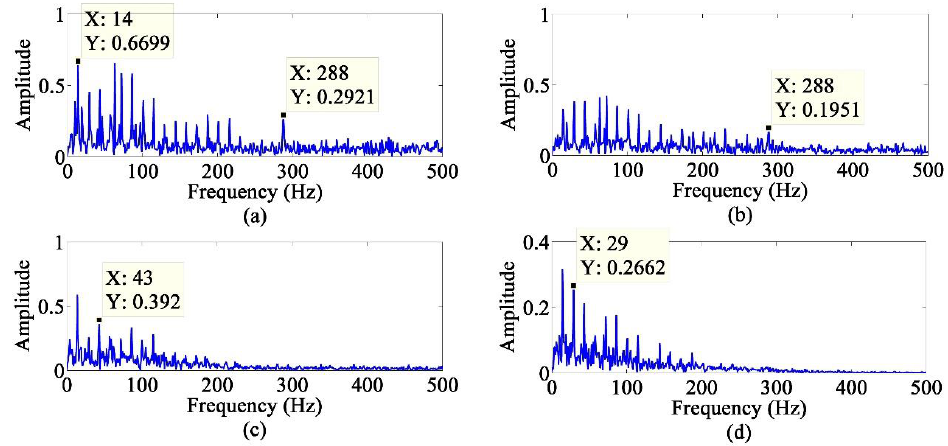
Figure 7. The Hilbert envelope spectra of each IMF after ensemble empirical mode decomposition (EEMD). ( a ) IMF1. ( b ) IMF2. ( c ) IMF3. ( d ) IMF4.